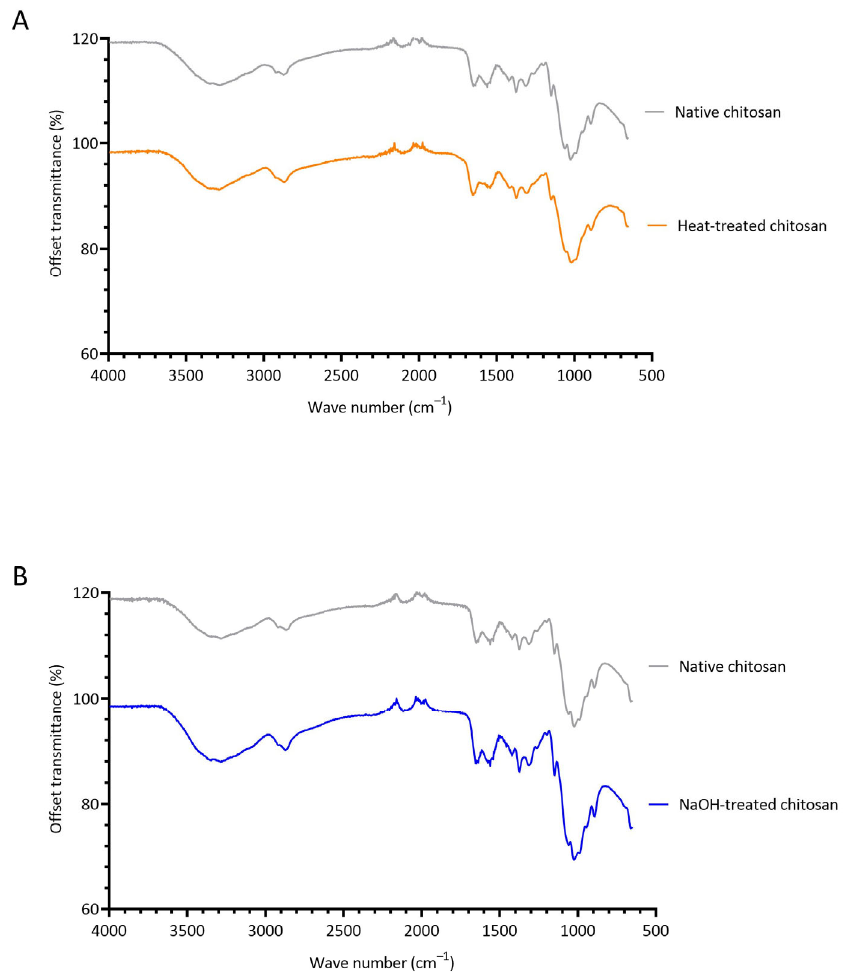
Figure 4. FTIR spectra of native chitosan powder vs. heat-treated chitosan powder (heated at 180 ◦ C for 1.5 h) ( A ) and native chitosan powder vs. NaOH-treated chitosan (treated with 1.0 M NaOH solution for 2 h, washed with endotoxin-free water and dried at 37 ◦ C for 24 h) ( B ). 3.4. Lysozyme Degradation of Chitosan ‐ Genipin Hydrogels Made Using NaOH Treated Chitosan